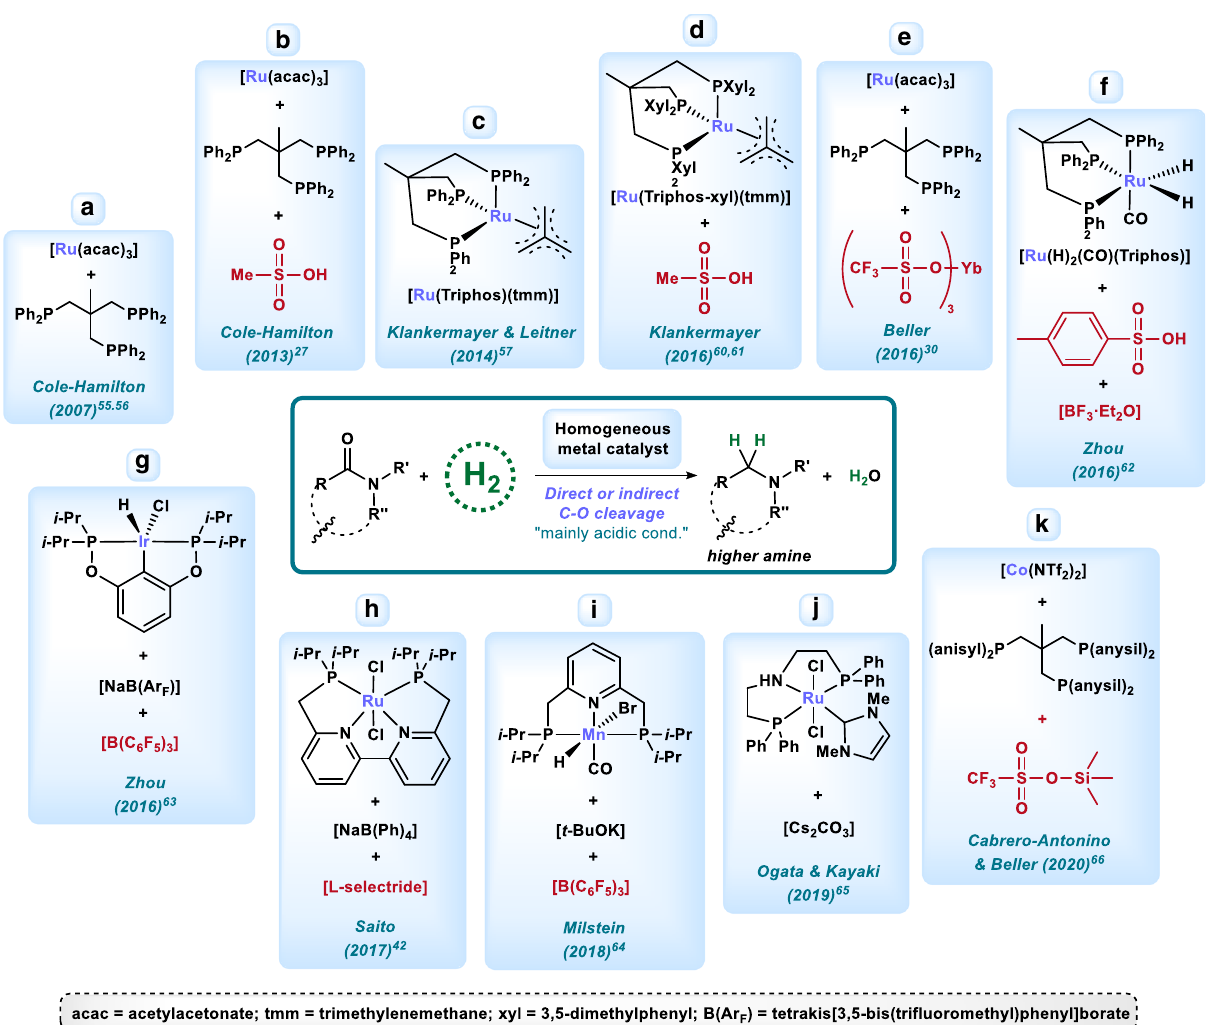
Fig. 3 Deoxygenative hydrogenation. Schematic representation of homogeneously catalyzed deoxygenative hydrogenation of amides to amines and the corresponding molecular catalysts used for the